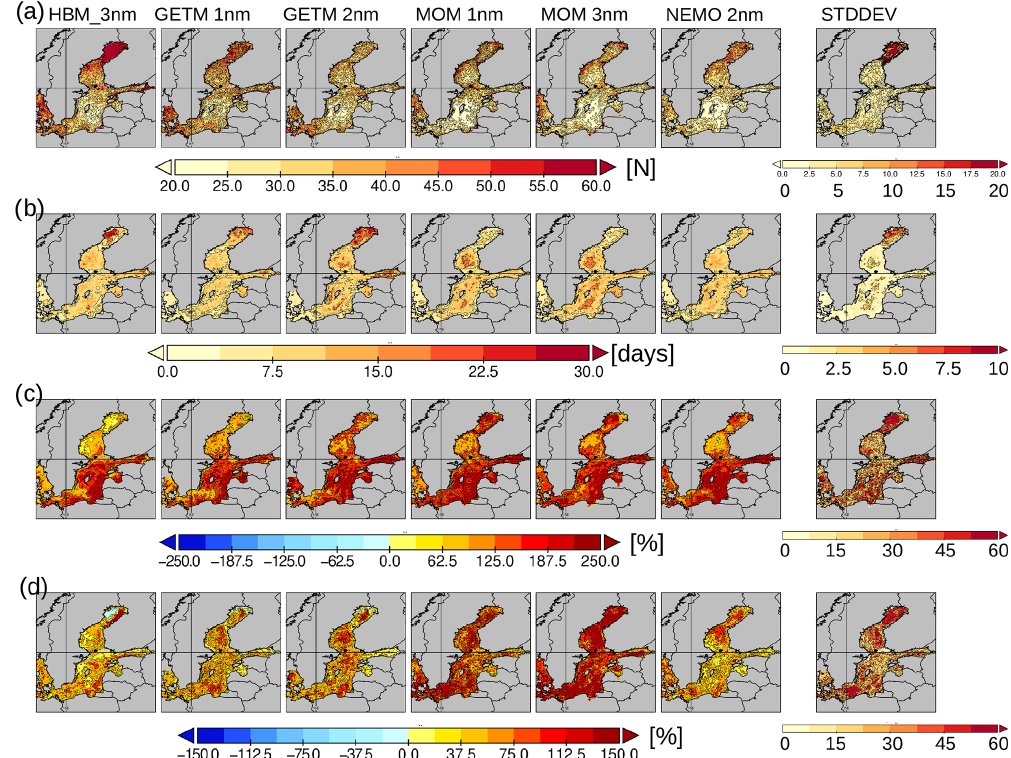
Figure 11. (a) Total number of MHWs with a duration of at least 5 consecutive days (class I or stronger) during the period 1965–1989. (b) Average MHW duration (class I or stronger). (c) Relative change in the number of MHWs between the period 1994–2018 and the period 1965–1989. (d) Same as panel (c) but for the average MHW duration. Note the different scaling of panels (c) and (d) . STDDEV in the rightmost column indicates the cross-model standard deviation and has its own color